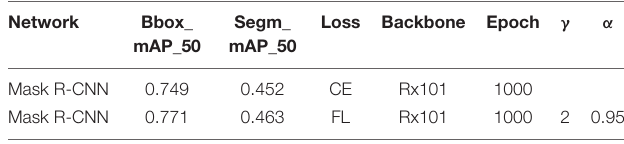
TABLE 5 | Training parameter and test results based on Mask R-CNN with different loss functions.